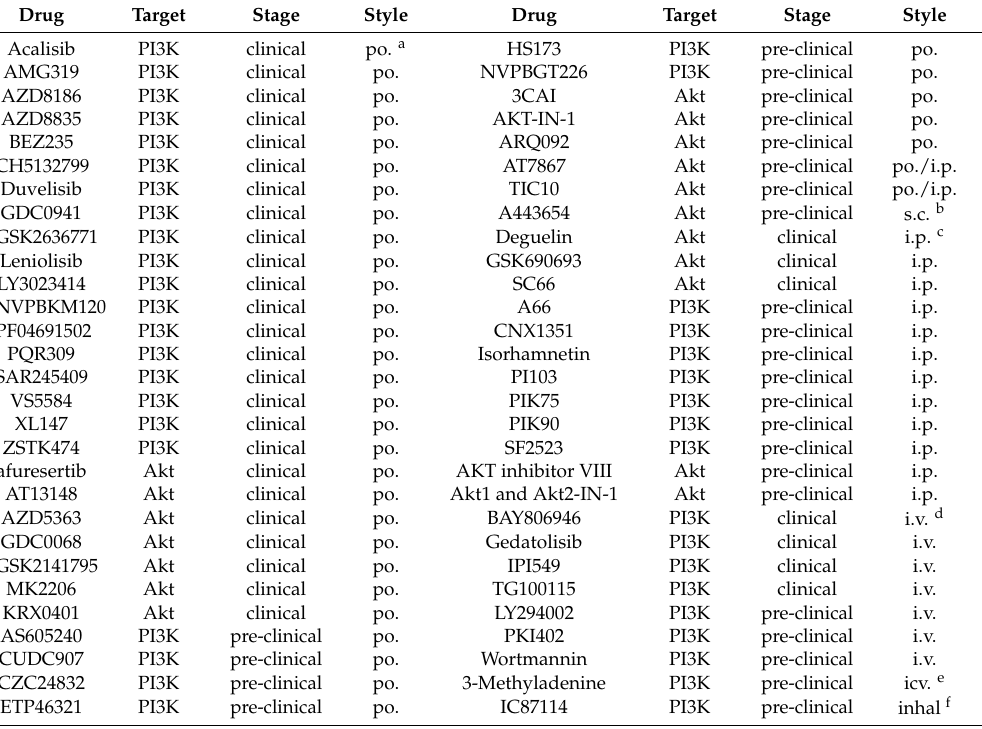
Table 1. Summary of Drugs targeting